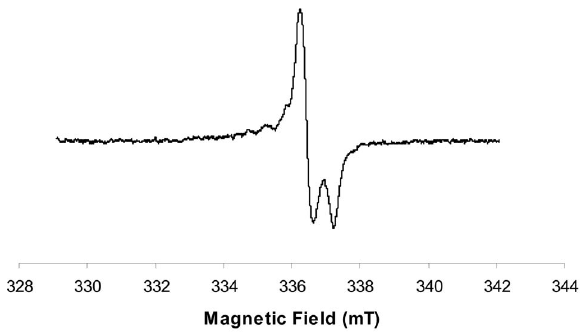
Figure 2. EPR dosimetric signal induced by radiations in tooth enamel.